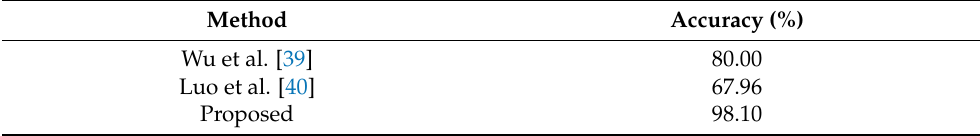
Table 5. Comparison with state-of-the-art approaches over the IDRiD